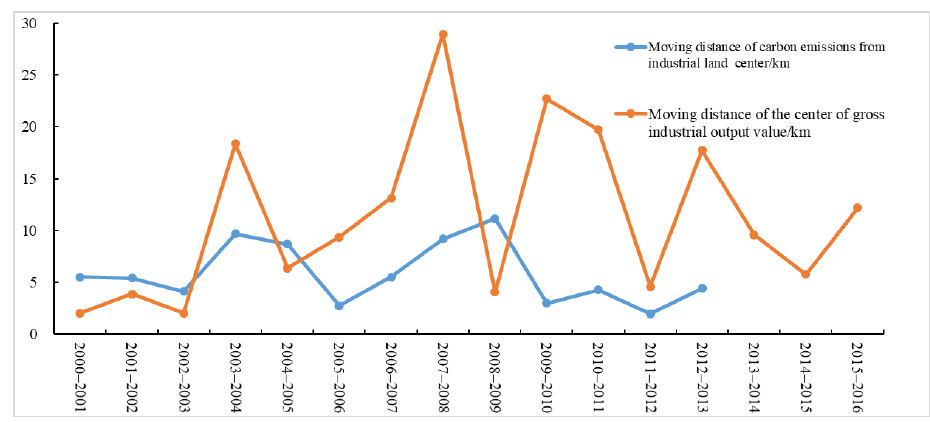
Figure 12. Comparison of the movement rates of the standard deviation ellipses of the GIOV center and CEIL center in Anhui Province from 2000 to 2016.